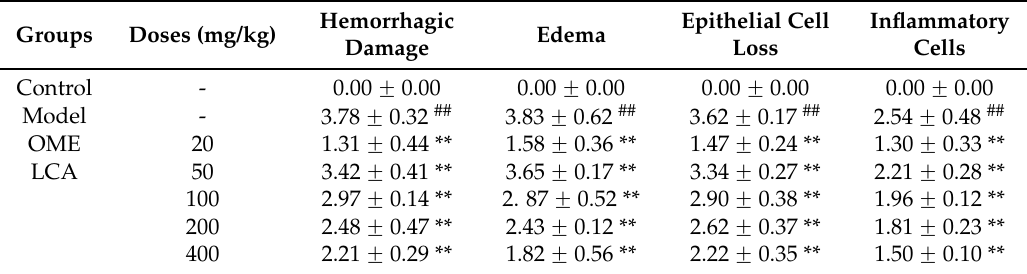
Figure 6. Effects of LCA on histopathological gastric lesions in mice. ( A ) Control; ( B ) model; ( C ) ethanol + OME 20 mg/kg; ( D ) ethanol + LCA 50 mg/kg; ( E ) ethanol + LCA 100 mg/kg; ( F ) ethanol + LCA 200 mg/kg; ( G ) ethanol + LCA 400 mg/kg. Arrow indicating necrotic lesions, oedema, leukocyte infiltration and disrupted cell architecture (Original magnification 100 ×). Table 1. Protective effect of LCA on ethanol induced microscopic damage in the gastric mucosa.